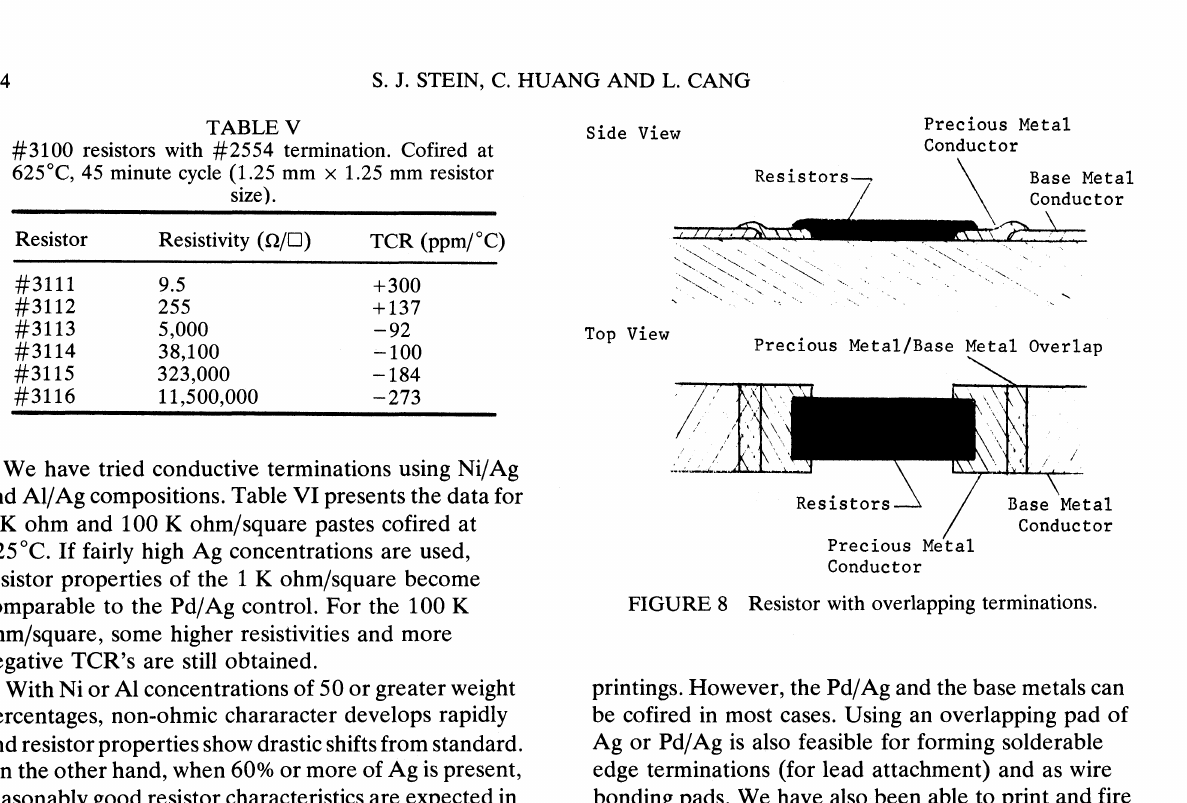
TABLE V #3100 resistors with #2554 termination. Cofired at